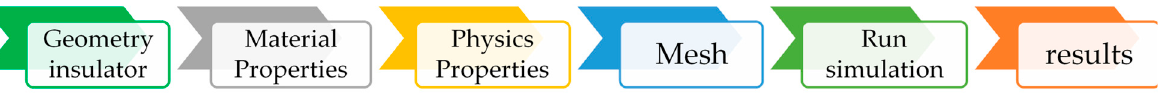
Figure 11. FEM modeling process in COMSOL Multiphysics.